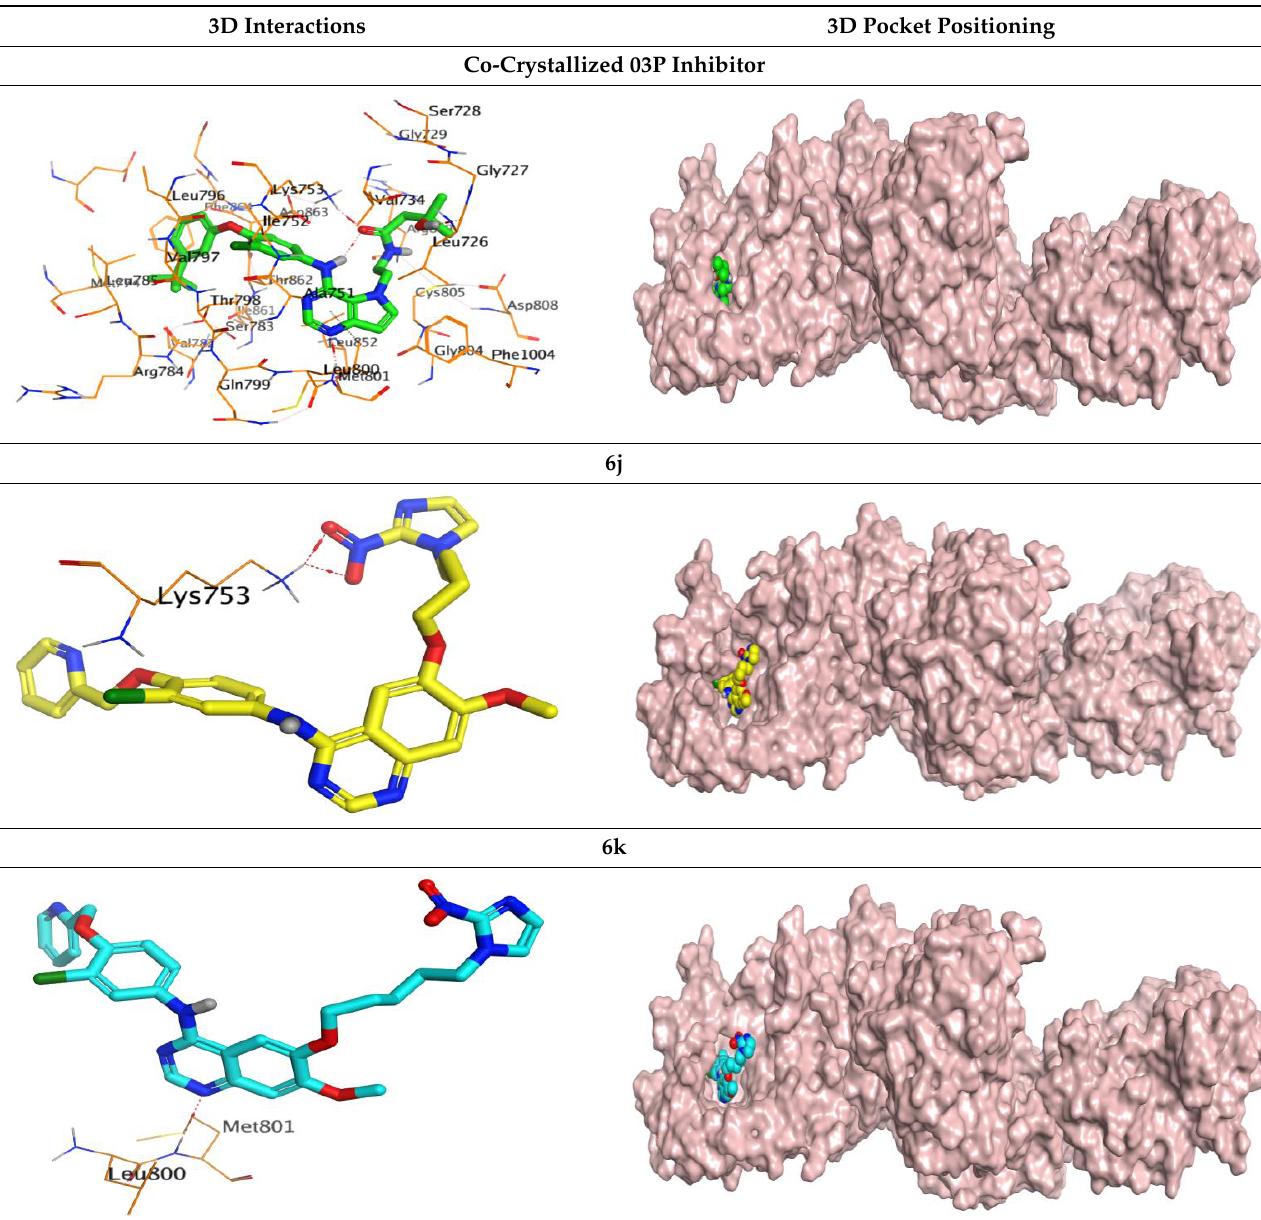
Table 7. 3D binding interactions and positioning of the co-crystallized AQ4 inhibitor, 6j , and 6k candidates within the HER2 (PDB ID: 3RCD) binding pocket.